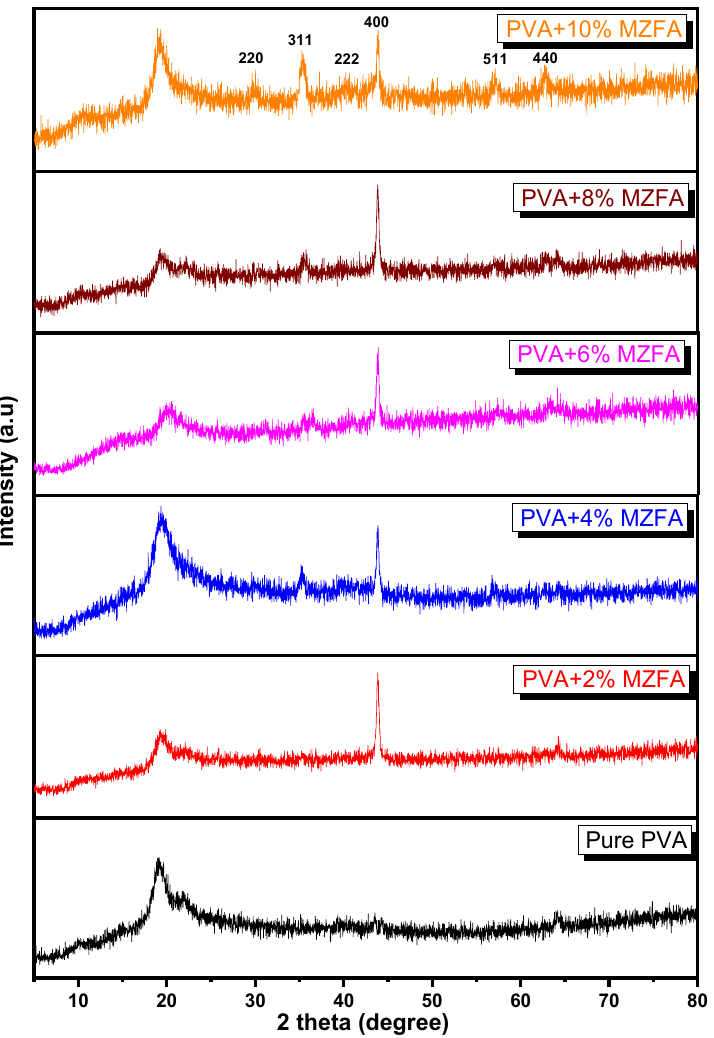
Figure 3. XRD patterns of the pure PVA polymer and synthesized PVA/MZFA composite films. The interchain separation (R), crystallite size (L), dislocation density ( δ ), interplanar distance (d), distortion parameters (g), and microstrain ( ε ) were calculated using the following equations [76–78]: